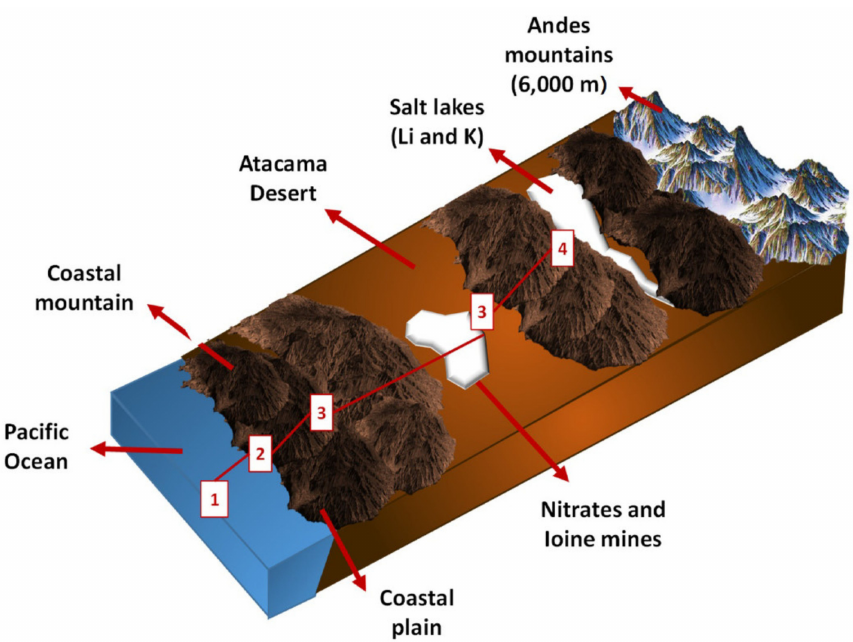
Figure 2. Geographic scheme of the Antofagasta region in Chile, mining activities and seawater collection system (Modified from: